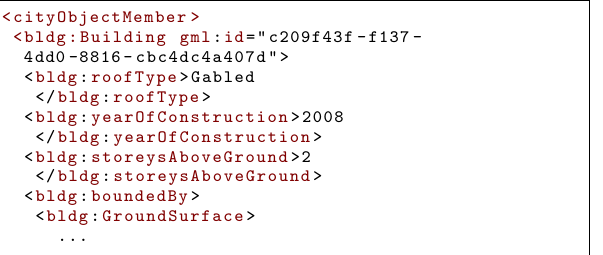
Figure 8: Excerpt of the generated CityGML 2.0 dataset.